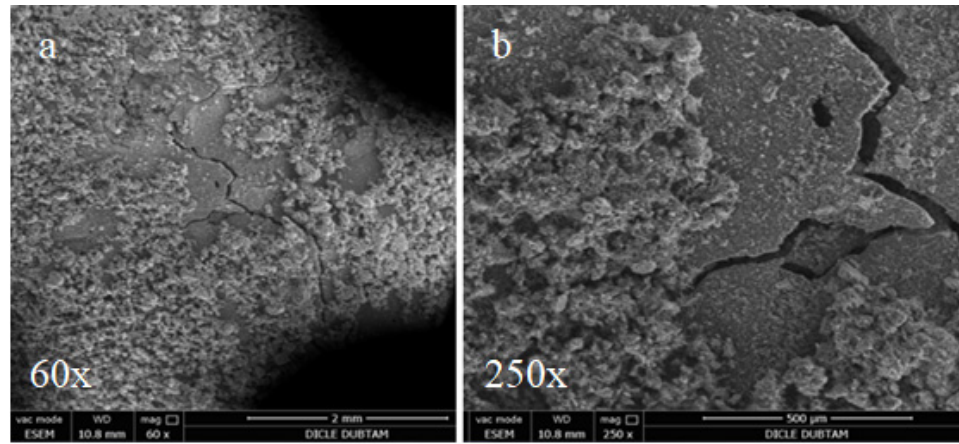
Figure 15. SEM images of SFS replacement bar samples cured for 90 days in sulphate solution: ( a ) 60×; ( b ) 250×.